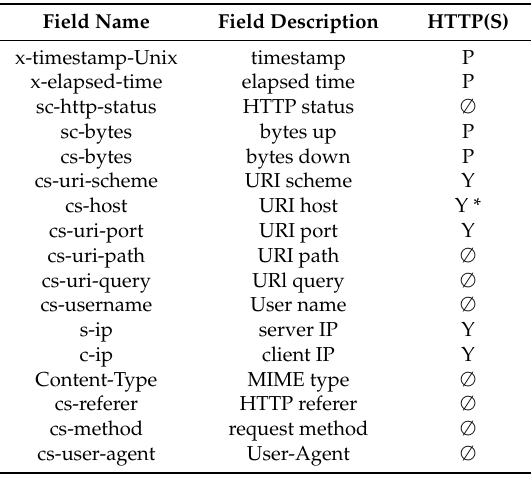
Table 1. HTTP(S) Flow Fields in